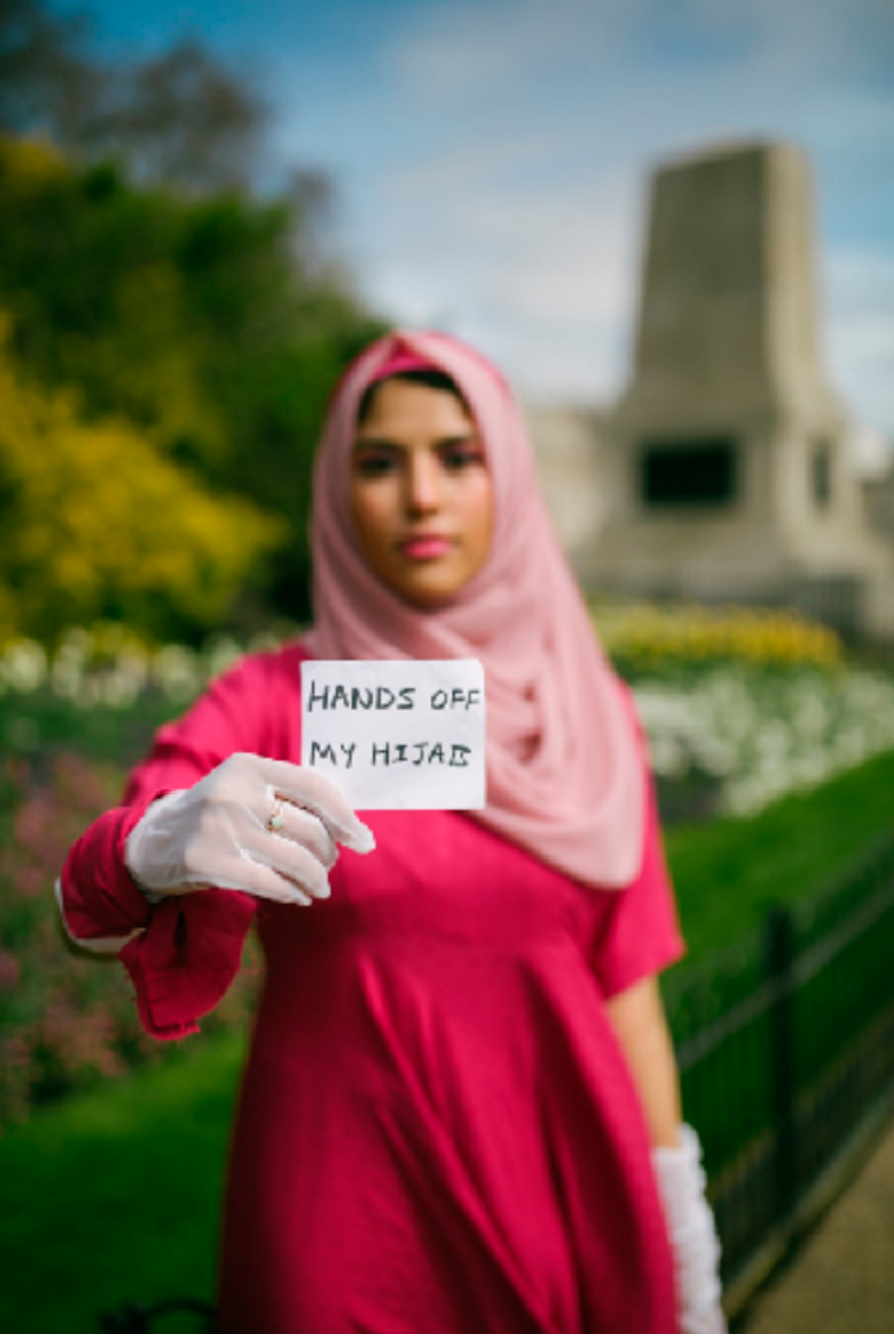
Figure 3. Macro-meme example which contrasts Homo Religiosus versus Ridens in what concerns attitudes towards women’s rights (Zaman 2021, picture used with the permission by Nabeela